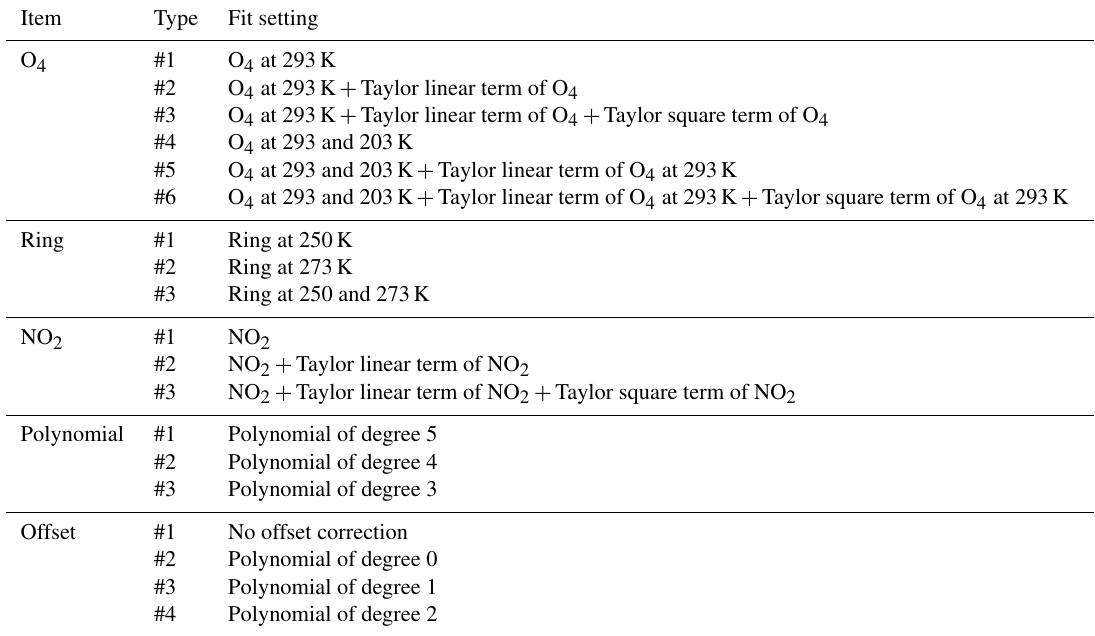
Table 4. DOAS fit settings for the sensitivity studies with respect to O 4 , Ring, NO 2 , polynomial and intensity offset correction in Sect.